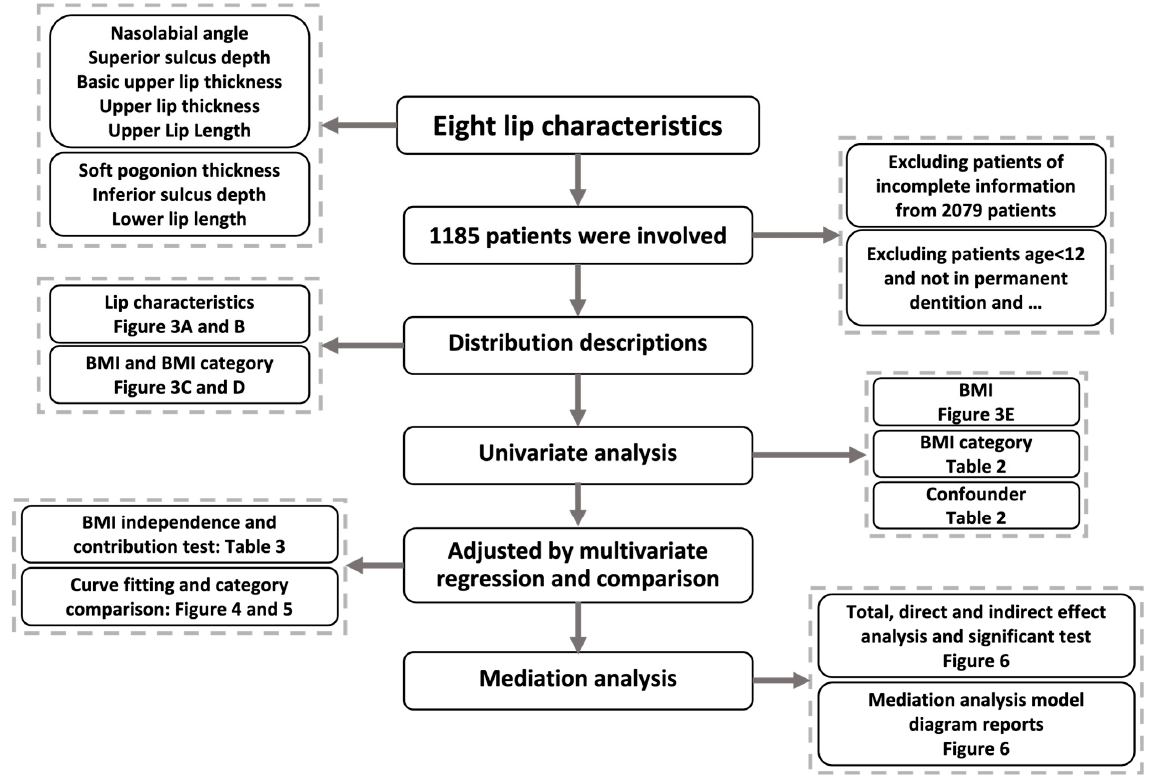
Figure 1. Study flow chart demonstrates the analysis process and content of the research. Lateral cephalometric radiographs were taken using the same device (Veraviewepocs, Morita, Kyoto, Japan). Patients were in their natural head position and centric occlusion, and were instructed to stay relaxed and not compress their lips during exposure. Pre-treatment cephalometric radiographs were imported into Dolphin imaging soft- ware version 11.9.07.23 (Patterson Dental, Los Angeles, CA, USA), independently traced and measured by two experienced orthodontists, the mean values of which were used for subsequent analyses. A total of 7 linear parameters and one angular parameter were meas- ured using cephalometric landmarks. Landmarks, reference lines and measurements used in this study are shown in Figure 2A. The cephalometric landmarks are defined in Table 1. Table 1. Cephalometric landmarks used in this